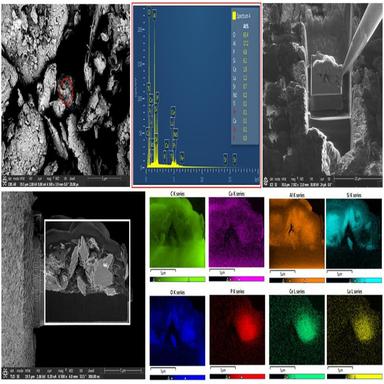
The enriched-phosphate particle selected for TEM-EDX analysis.